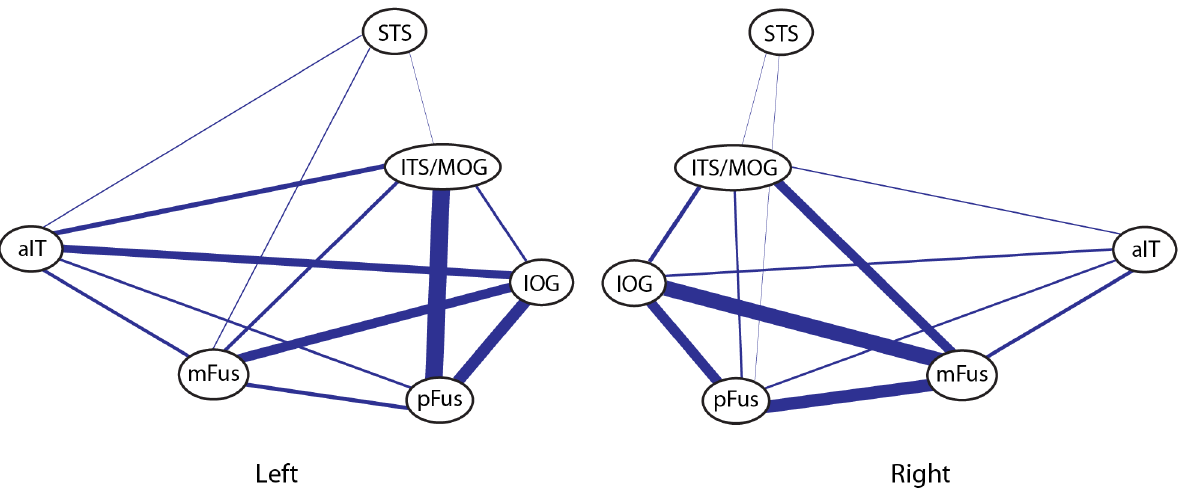
Figure 8. Connectivity diagram showing connections between all face-selective ROIs in both hemispheres. Line thickness is scaled to reflect the mean track count across all participants. The aFus ROI is not shown as it was only present in 3 of 10 hemispheres.